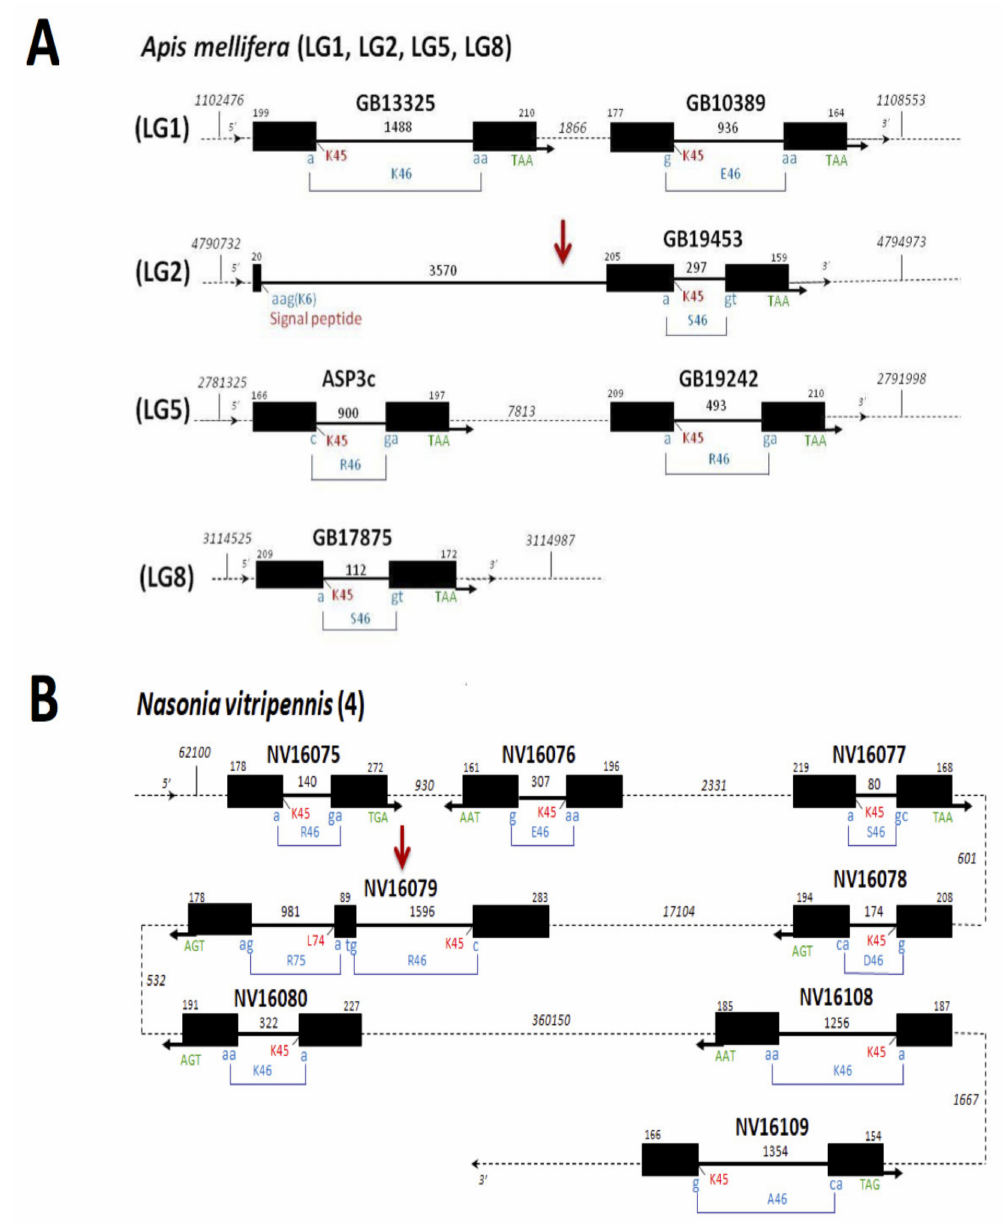
Figure 2. Genomic organization of Apis and Nasonia CSPs . ( A ) Genomic organization of A. mellifera CSPs on four di ff erent chromosomes (LG1, LG2, LG5 and LG8) ( B ) Genomic organization of N. vitripennis CSPs on chromosome 4. Exons are shown as black boxes, introns as bold black plain lines and intergenic intron regions as dotted lines. The numbers above the box and the plain line give the exon and intron size, respectively. The numbers in italics above the line give the distances between genes. Exon / intron sizes and intergenic distances are given in base pairs. The amino acid residue in red indicates the intron insertion site (K45, L74 or signal peptide). In blue is shown the triplet codon for the amino acid interrupted by intron insertion. Stop codons are indicated in green ( Apis : TAA; Nasonia : TAA or TGA, A > G switch in stop codon). Horizontal arrow in black indicates the orientation of the gene: 5 (cid:48) –3 (cid:48) (right) or 3 (cid:48) –5 (cid:48) (left). The red vertical arrow points out the di ff erent position of the double-intron CSP gene in A. mellifera and N. vitripennis ,